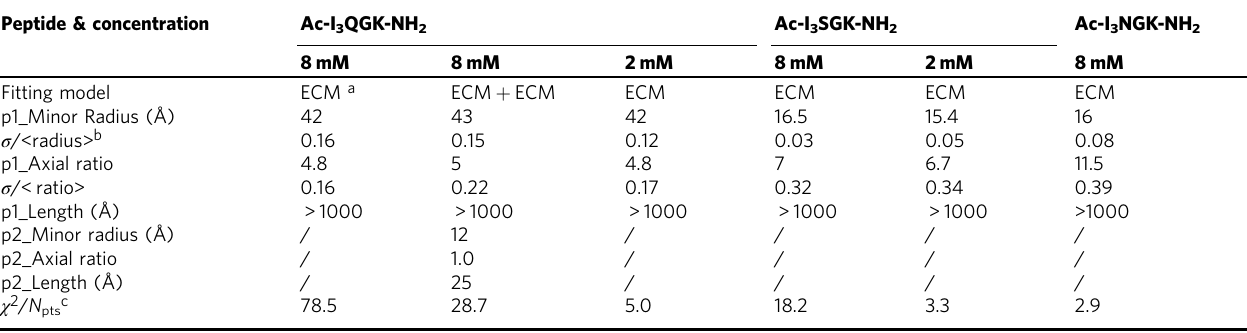
For clarity, other structural parameters are given in Supplementary Table 1. During the fi tting process, the incorporation of size polydispersity into the minor radius and axial ratio of long and wide nanoribbons could improve the fi tting quality but had little impact on their main structural parameters a ECM denotes the elliptical cylinder model b σ = standard deviation of the lognormal distribution and <> = mean value c χ 2 / N pts values were signi fi cantly decreased in the presence of size polydispersity for the minor radius and axial ratio of long and wide ribbons, in comparison with those assuming an absence of size polydispersity (Supplementary Table